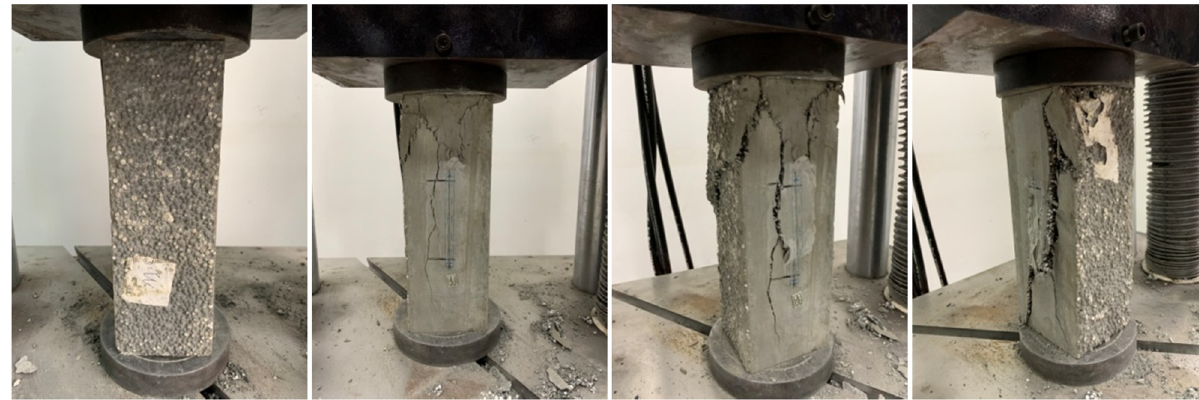
Figure 8: Failure mode of group W specimens.